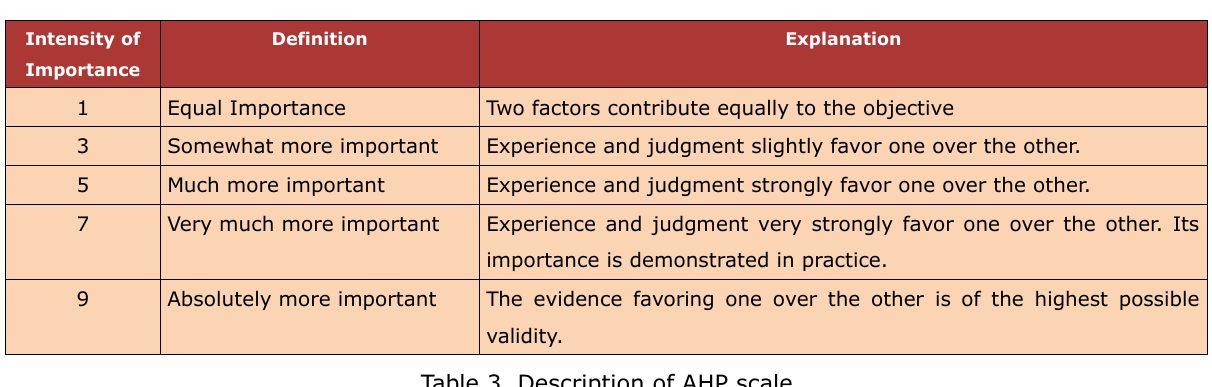
Table 3. Description of AHP